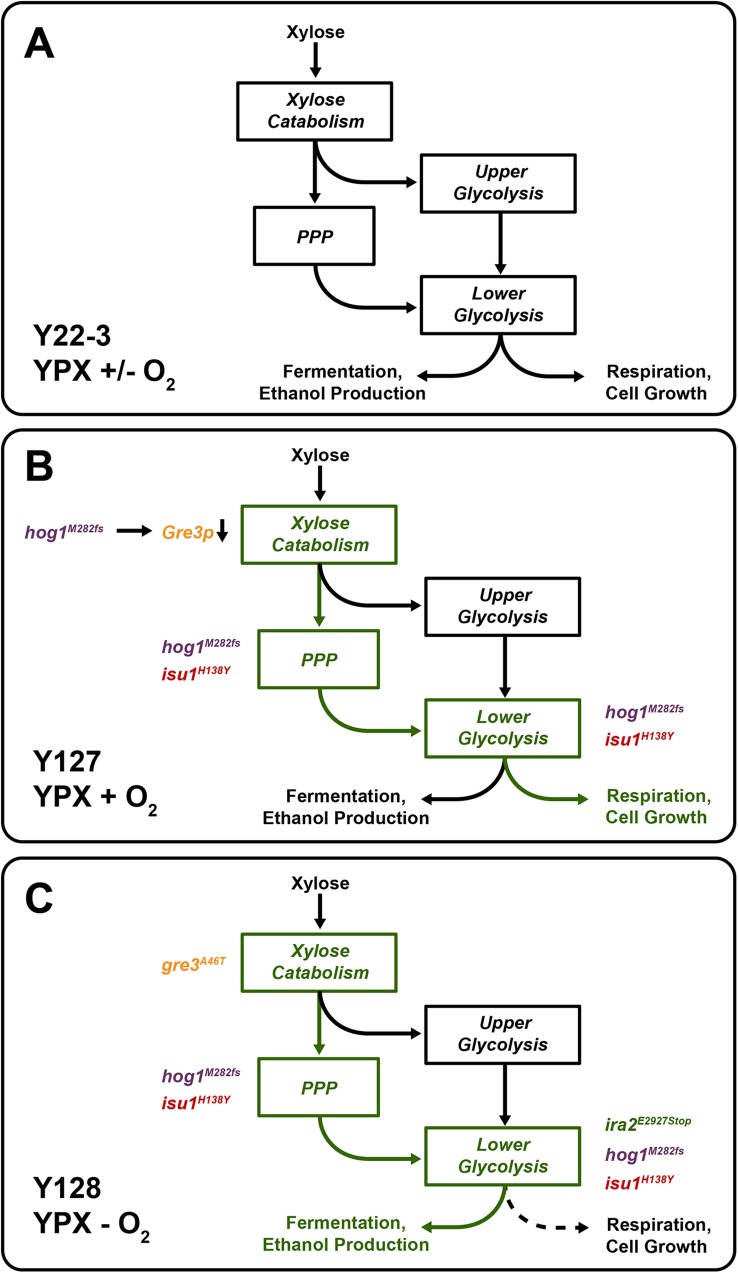
Proposed model for how the evolved mutations impact biochemical pathways for xylose metabolism.Text, shapes and arrows in green signify upregulated activities compared to the activities in the parental strain (in black). Under aerobic or anaerobic conditions, the parent strain consumes low amounts of xylose due to insufficient biochemical activities (A). Under aerobic conditions, the evolved hog1M282fs and isu1H138Y mutations enhance activities (signified in green) of the pentose phosphate and lower glycolytic pathways, as well as respiration, thereby permitting significantly greater growth on and metabolism of xylose (B). Loss of HOG1 function caused reduced expression of GRE3 and other targets that impair xylose metabolism. Under anaerobic conditions (C), the evolved ira2E2928Stop mutation causes activation of PKA, which in turn activates glycolytic enzymes. This, along with the disabling gre3A46T mutation, enables the fermentation of xylose into ethanol.